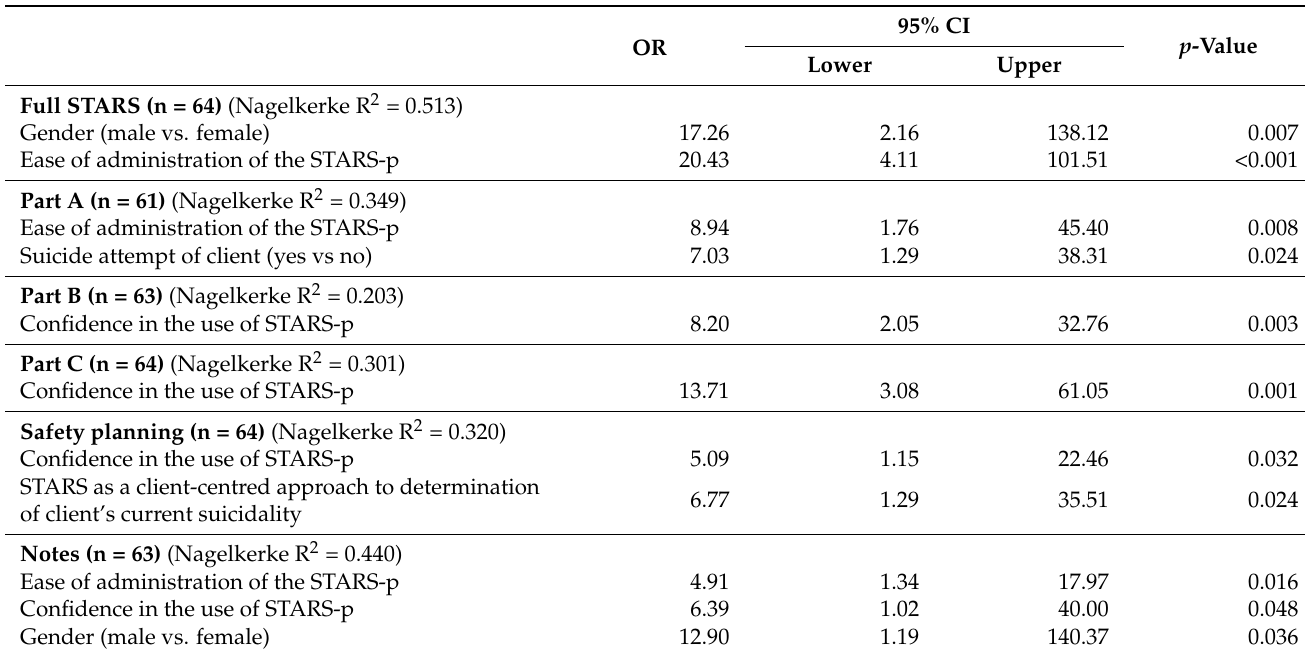
Table 4. Multiple logistic regression final models (likelihood ratio) of association with use of the STARS-p.